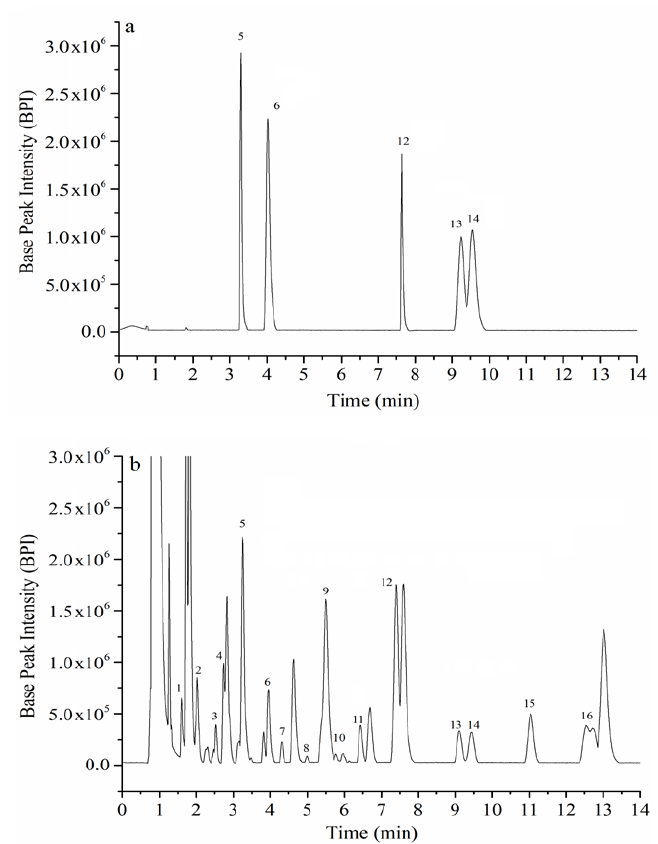
Figure 2. Ultra-performance liquid chromatography (UPLC) chromatograms of mixed standards ( a ) and sample ( b ). 1: Maslinic acid isomer-1 (Ma1); 2: Maslinic acid isomer-2 (Ma2); 3: Maslinic acid isomer-3 (Ma3); 4: Maslinic acid isomer-4 (Ma4); 5: Alphitolic acid (Aa); 6: Maslinic acid (Ma); 7: 2 α -hydroxy ursolic acid (2 α Ha); 8: Maslinic acid isomer-5 (Ma5); 9: Oleanolic acid isomer-1 (Oa1); 10: Maslinic acid isomer-6 (Ma6); 11: Maslinic acid isomer-7 (Ma7); 12: Betulinic acid (Ba); 13: Oleanolic acid (Oa); 14: Ursolic acid (Ua); 15: Betulonic acid (Ba’); 16: Oleanonic acid + Ursonic acid (Oa’ +